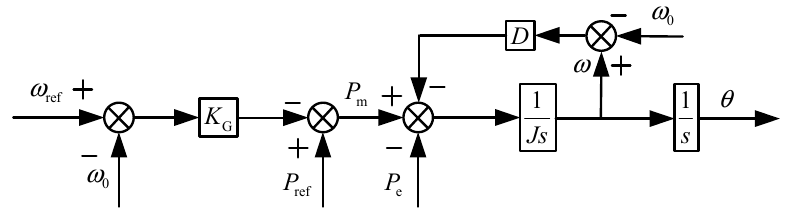
Figure 4. Active power–frequency modulation loop structure block diagram.